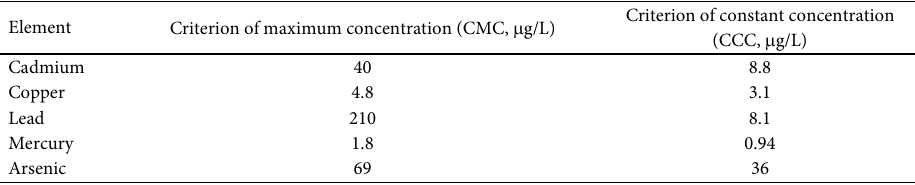
Table 1. Safety limits (criteria) set by US-EPA for concentration of heavy metals on Sea